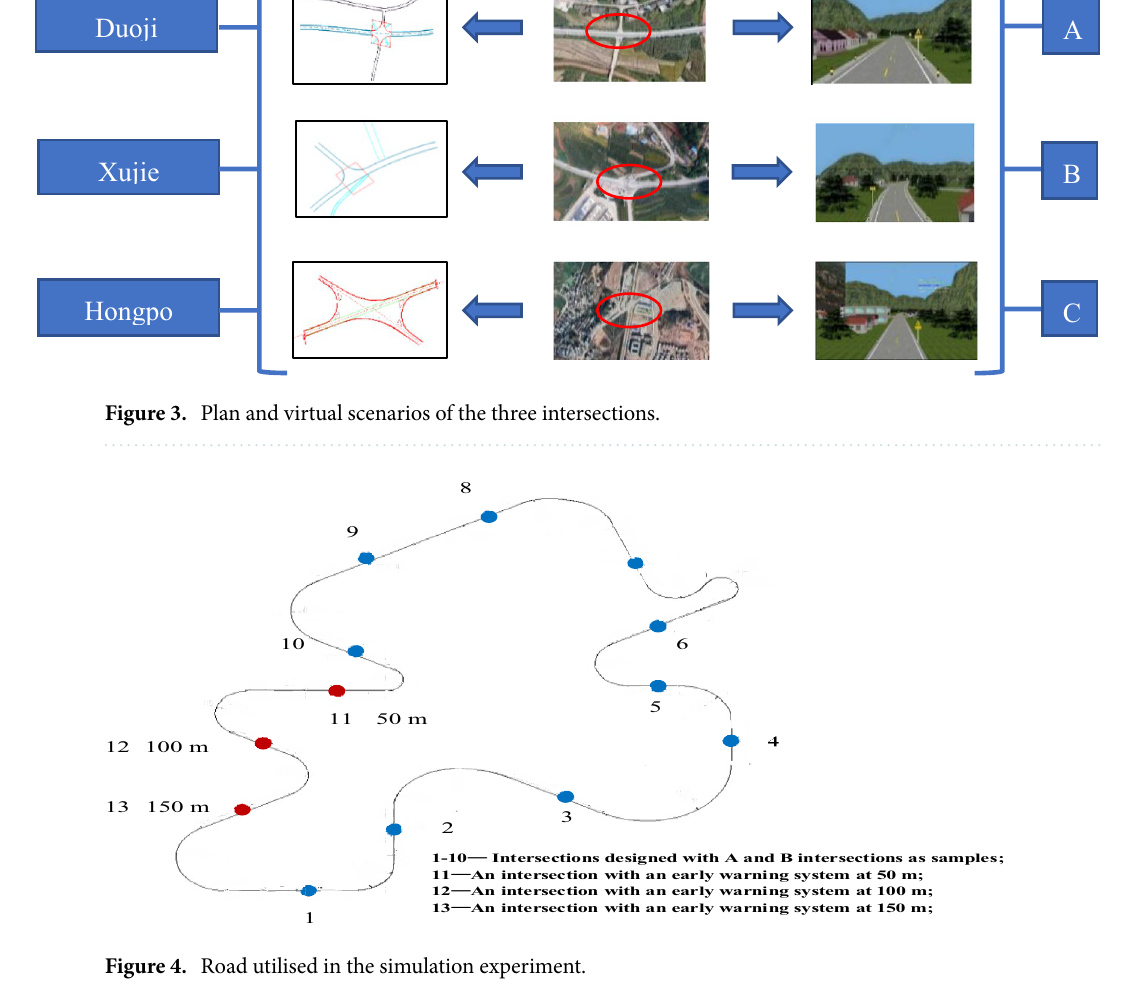
Figure 4. Road utilised in the simulation experiment.